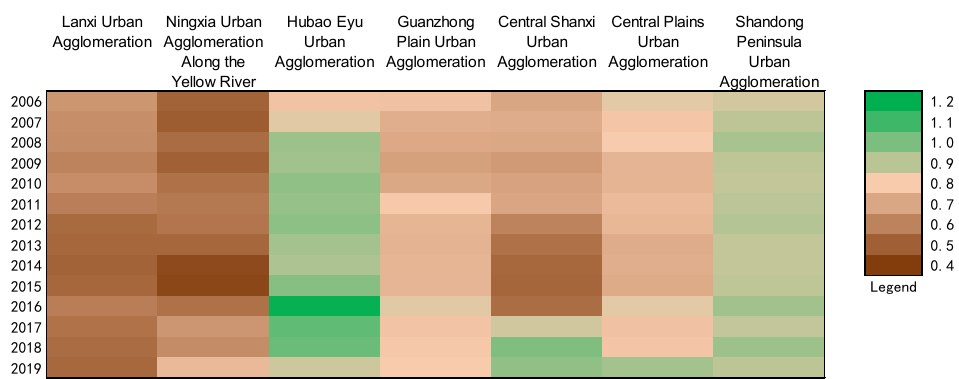
Figure 4. Heat map of ecological efficiency of urban agglomerations in the Yellow River basin, China.